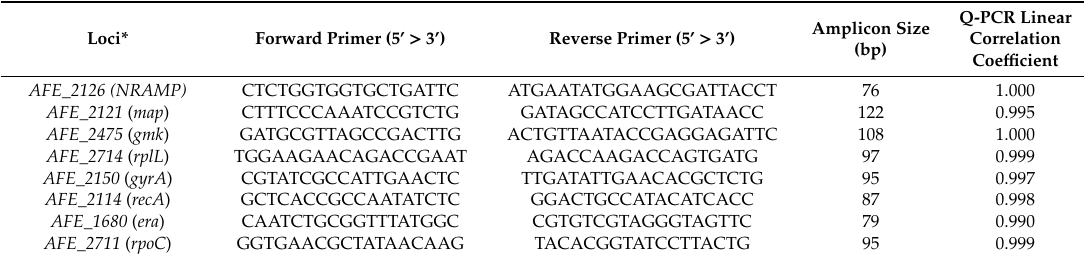
Table 1. Reference genes, qPCR primers, and reaction